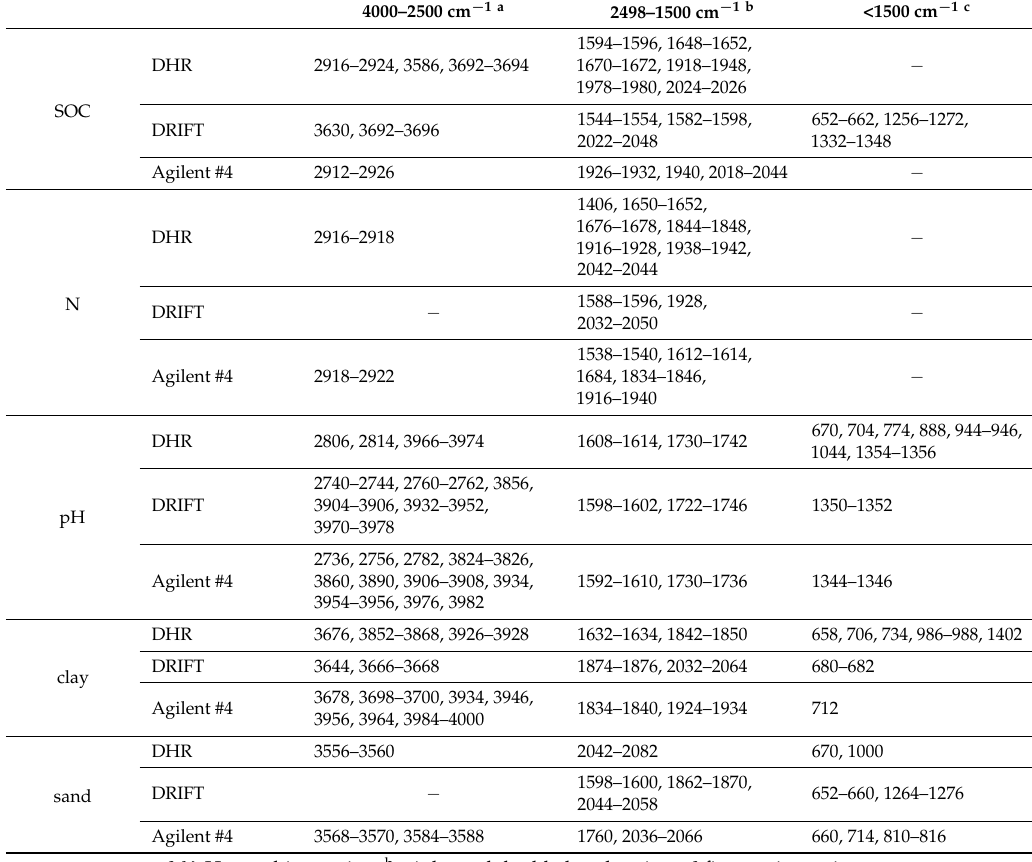
Table 4. Spectral key regions identified from Monte Carlo CV CARS